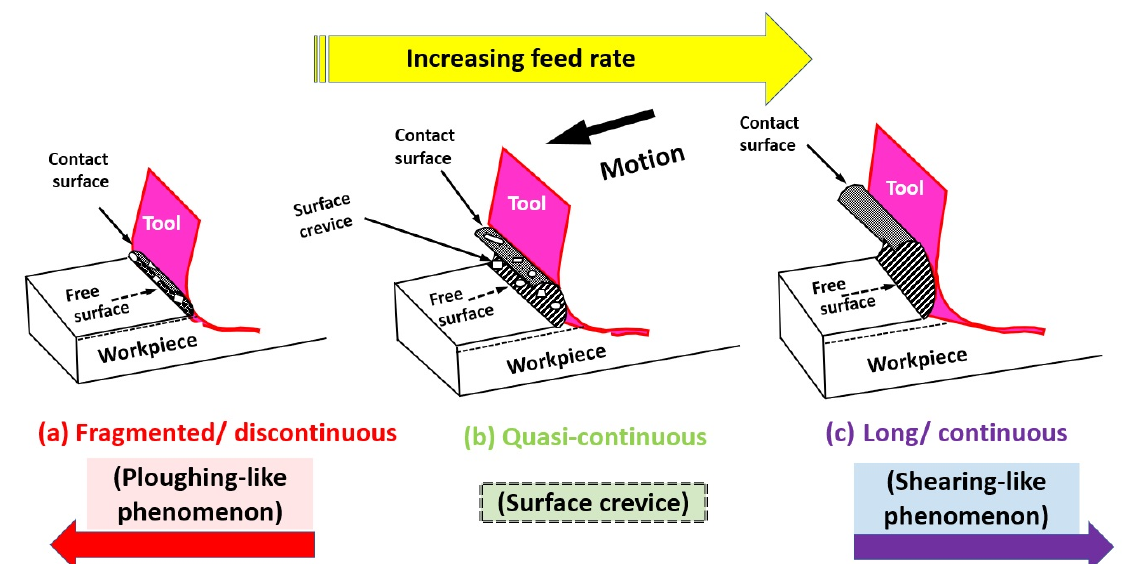
Figure 16: Schematic of FRR (feed rate response) on the mechanics on chip formation Figure 16. Schematic of FRR (feed rate response) on the mechanics on chip